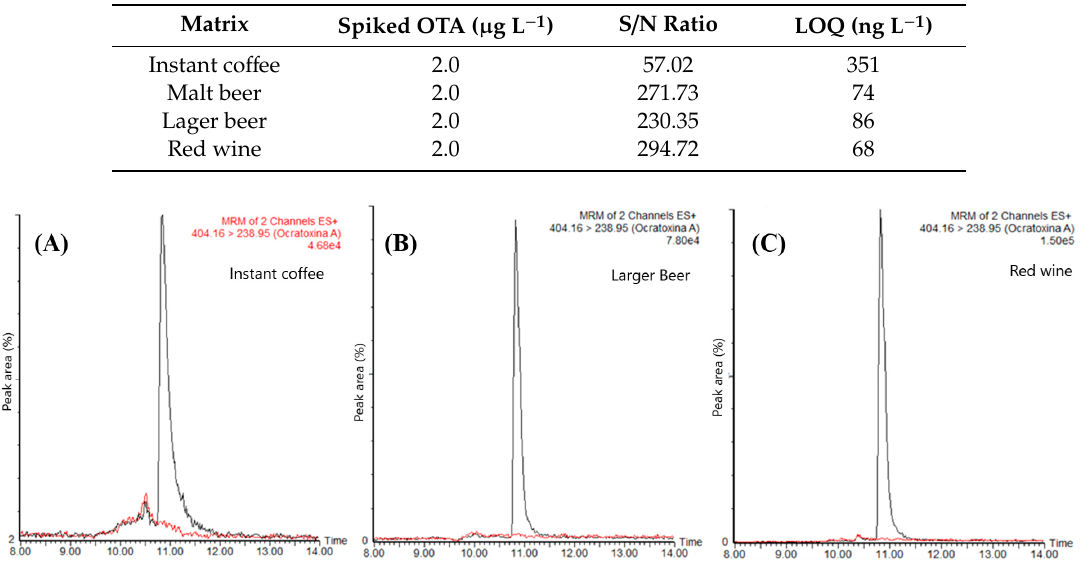
Figure 2. Superposition of the SRM (selected reaction monitoring) chromatograms of OTA ion transition ( m / z 404.1 → m / z 238.9) from the analysis of ( A ) instant coffee, ( B ) beer, and ( C ) red wine samples fortified with OTA at 2.0 µ g L − 1 (black trace) and blank matrix sample (red Table 1. Evaluation of the OTA m / z 404.1 → m / z 238.9 ion transition response as a function of the analyzed matrix.